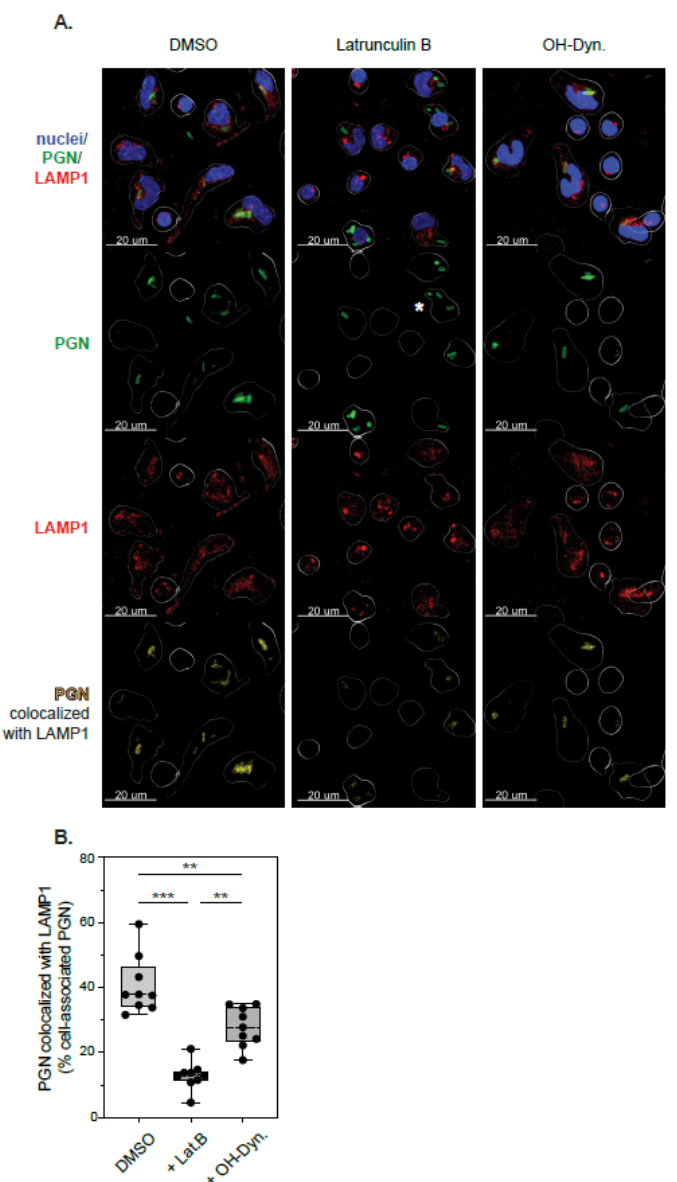
Figure 5. Phagolysosomal trafficking of PGN after inhibition of actin and/or dynamin-dependent internalization. ( A ) Representative confocal micrographs depicting phagolysosomal trafficking of PGN-FITC in a median responsive individual in the absence (left column) or presence of internali- zation inhibitors (middle and right columns). Top row illustrates maximum intensity projections of confocal z-stacks showing PGN (green), LAMP1 (red) and cell nuclei (blue). Middle rows depict individual PGN (green) and LAMP1 (red) signals in monocytes, while the bottom row shows cell associated PGN that colocalizes with LAMP1 (yellow). In all panels, the monocyte envelope was projected by 3D rendering of CD14 staining using Imaris and is depicted as an intermittent white line to highlight cellular regions. The colocalization signals were generated in Imaris based on the co-distribution of individual PGN and LAMP1 signals in z-stack datasets. Note the reduction in colocalization signals (bottom panels), primarily in latrunculin-treated cells. Internalized PGNs with no associated LAMP1 were consistently observed in latrunculin-treated cells and are highlighted (*) in the middle panel. ( B ) Graphical representation of latrunculin- and dynasore-induced changes in PGN-LAMP1 colocalization in monocytes isolated from 9 independent donors. Individual responses represent the mean volume of cell-associated PGN that colocalizes with LAMP1 from 5 independent confocal z-stacks per donor. Statistically significant differences between experimental groups are depicted conventionally (** p < 0.01, *** p <